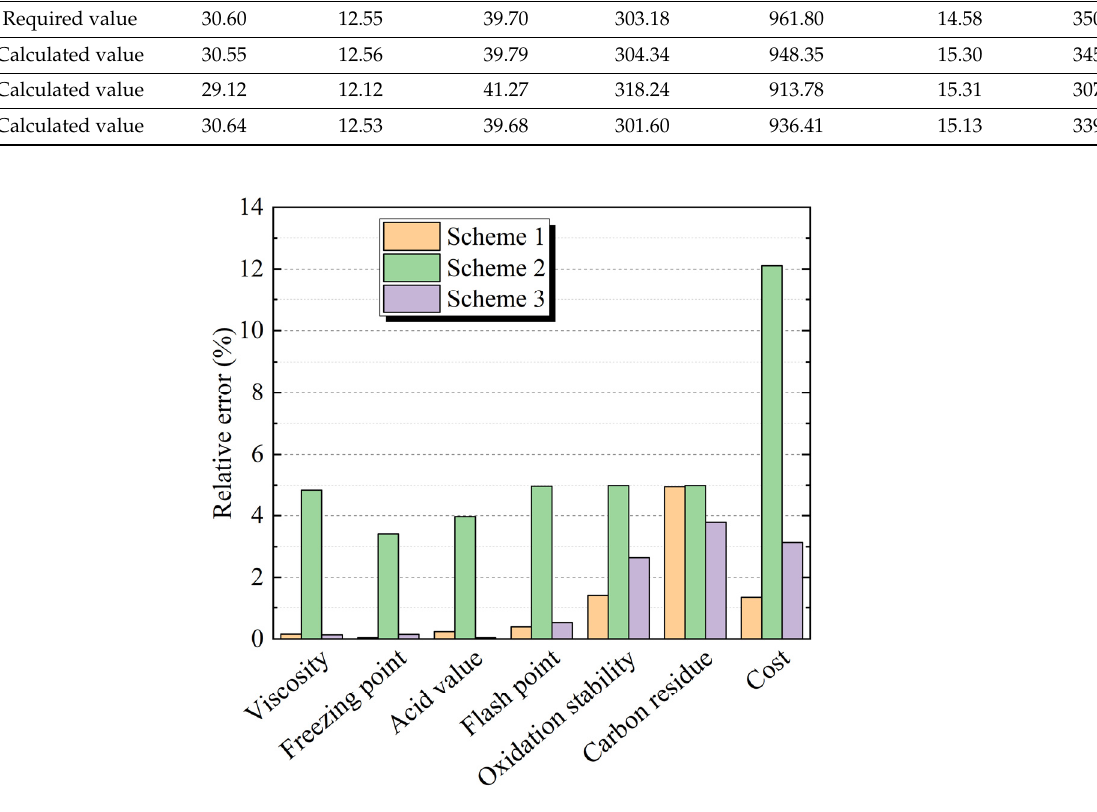
Figure 5. Comparison of the relative error between the calculated value and required value of the index and the cost.